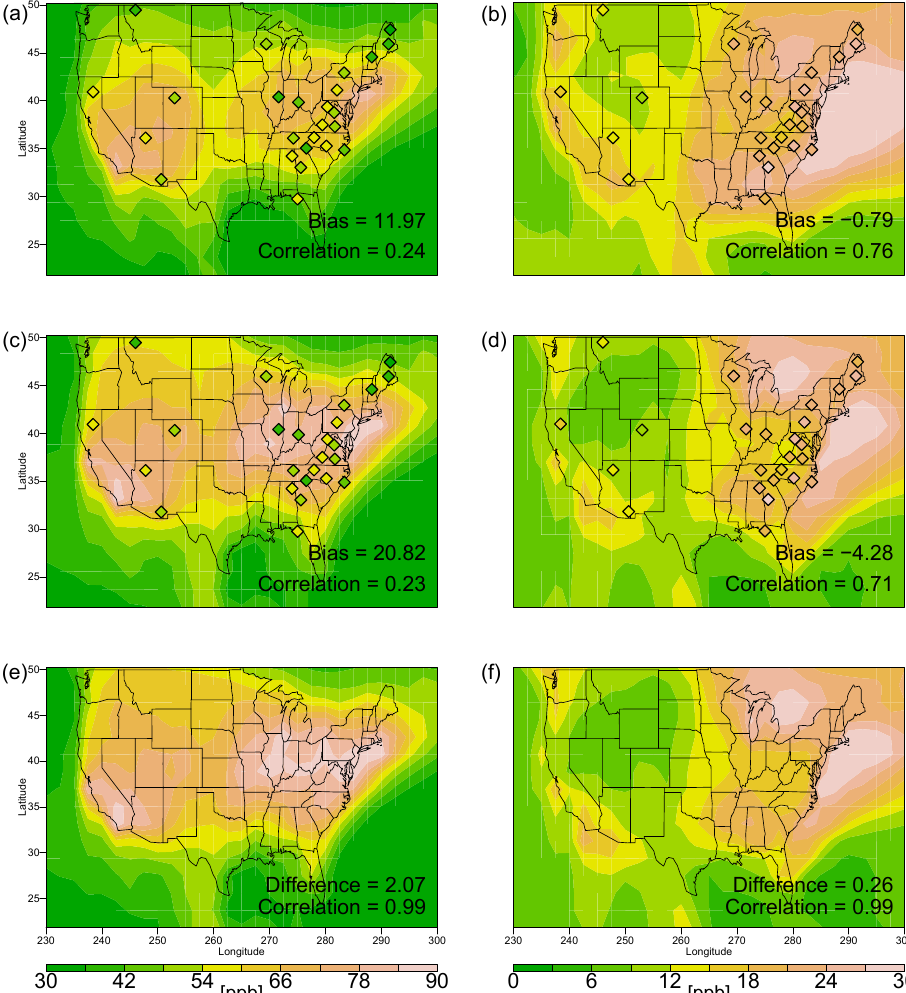
Figure 3. Rescaled data. Average MDA8 ozone (ppb) (a, c, e) and average MDA8 ozone (ppb) conditioned on MDA8 ozone greater than the 90th percentile minus average MDA8 ozone (b, d, f) for the CESM1 REFC1SD simulation (1992–2010) (a, b) , the GCM2000 simulation (2006–2025) (c, d) and the GCM2100 simulation (2106–2125) (e, f) . The biases, differences and correlations are defined similarly to in Fig.